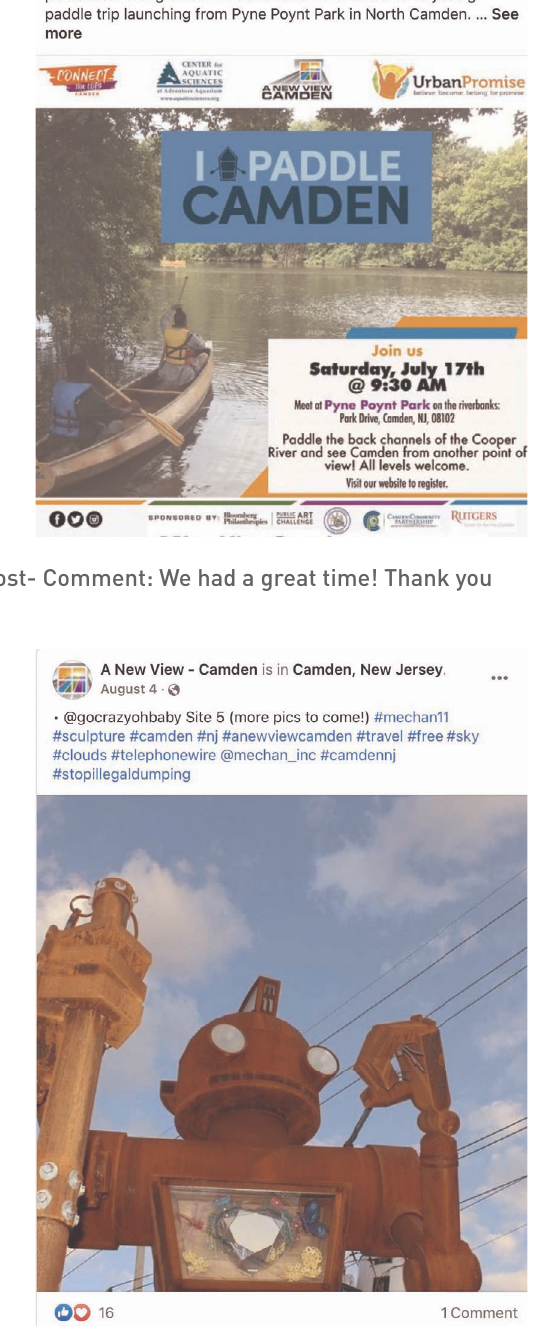
Facebook Post- Comment: Love seeing this guy when I drive